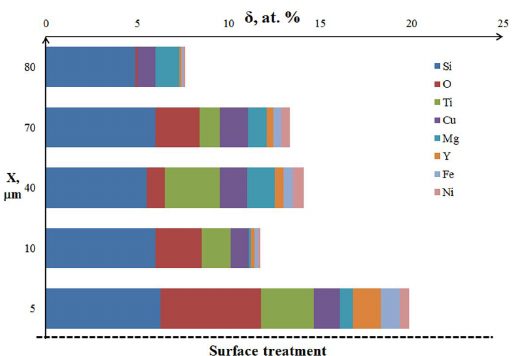
Figure 4. Dependence of concentration of Al-11wt%Si alloy chemical elements (excluding aluminium) subjected to complex treatment on distance (X) from the surface of